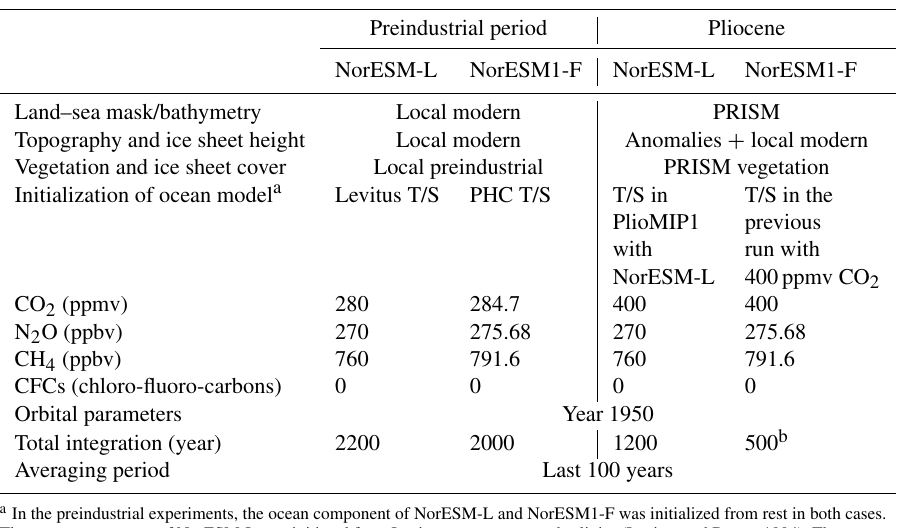
Table 2. Boundary conditions for the preindustrial and the Pliocene experiments.